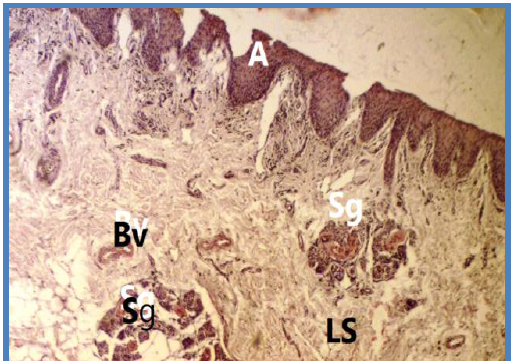
Figure (1): macrograph showing the regions of nasal cavity selected for the study: 1-nasal vestibule, 2- dorsal terbinate, 3-ventral terbinate , 4-cranial part of middle terbinate , 5-caudal part of middle terbinate .